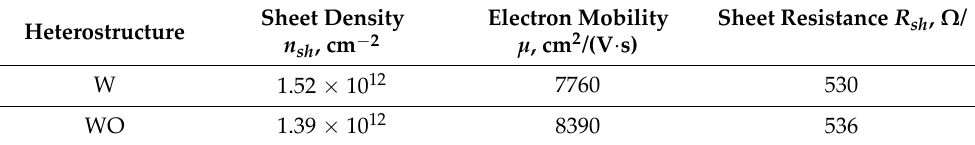
Table 1. Electrical parameters of the grown semiconductor layered structures.